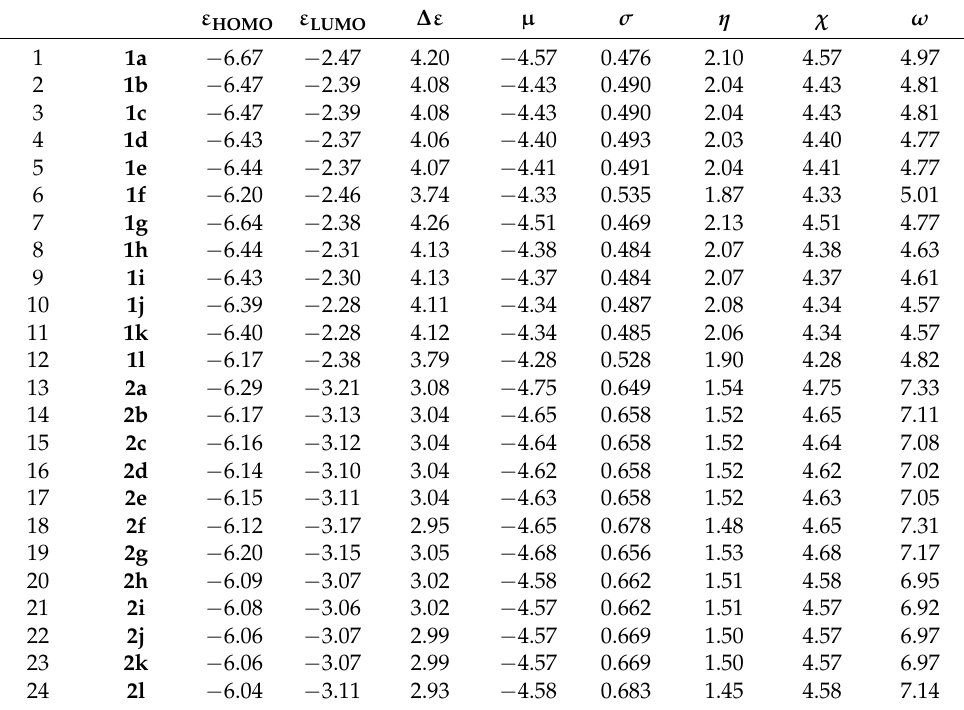
Figure 1. Molecular orbitals of triazolothiadiazine compounds 1a and 2a calculated on structures geometry optimized using B3LYP/6-311+G** density functional theory. Table 2. Frontier orbital parameters for triazolothiadiazine compounds calculated on geometry optimized structures at the B3LYP/6-311+G**